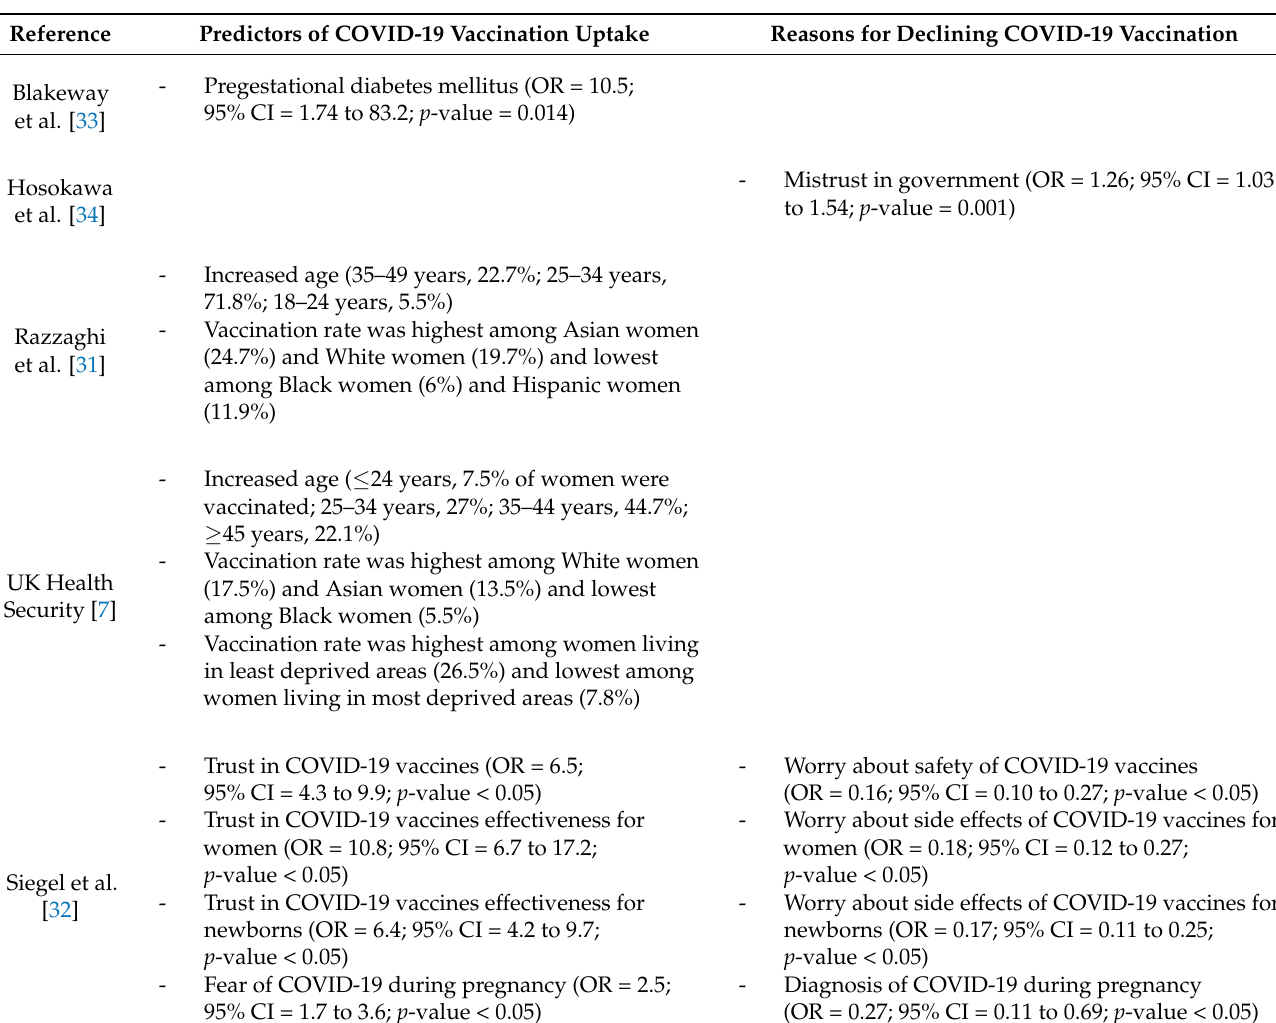
Table 2. Predictors of COVID-19 vaccination uptake among pregnant women and reasons for declining